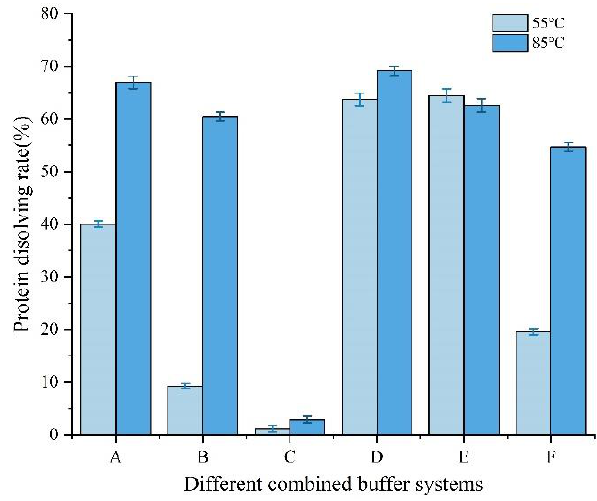
Figure 8. Protein solubility of EBN samples extracted from different combined buffer systems. All of the buffer system contained phosphate buffer solution. A, B and C were added 1% SDS, 8 M urea and 1% β -mercaptoethanol, respectively. D was the combination of 1% SDS and 8 M urea. E was the combination of 8 M urea and 1% β -mercaptoethanol. F was the combination of 1% SDS, 8 M urea and 1% β -mercaptoethanol.